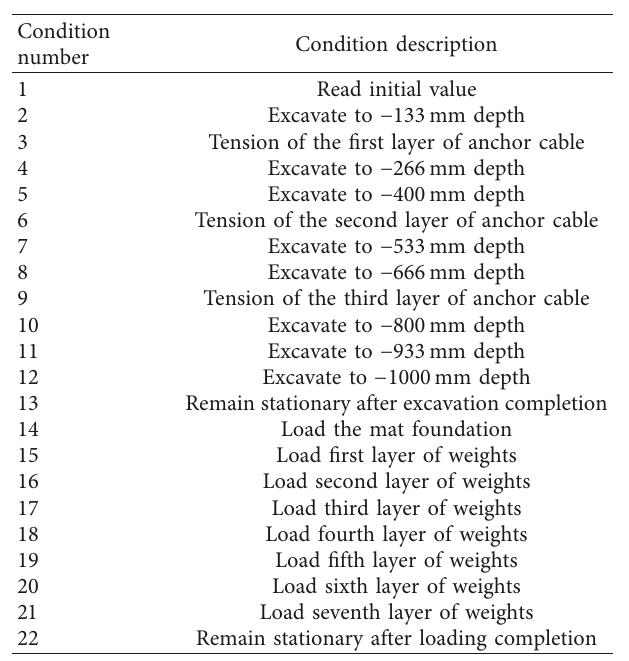
Table 4: Model test conditions for Scheme 3.